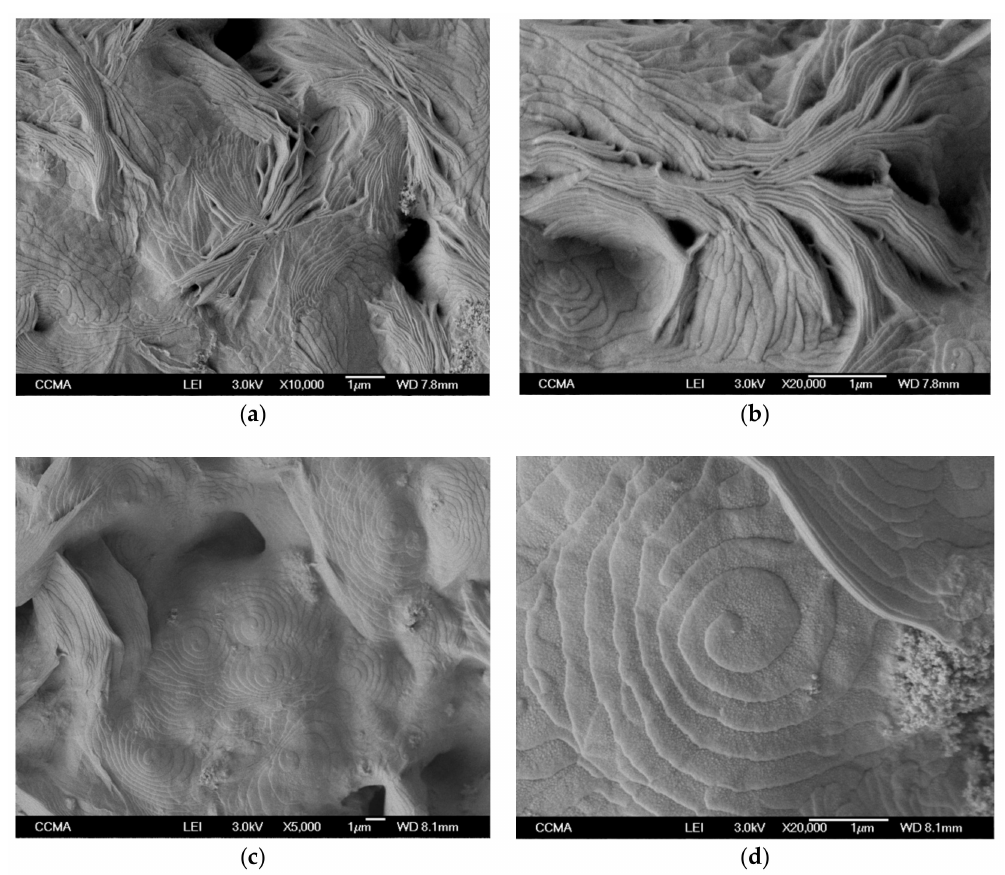
Figure 6. SEM micrograph of PTFE crystals formed in the presence of SiO 2 (c)F at ( a , b ) fast cooling rate (100 K · s − 1 ) and ( c , d ) slow cooling rate (0.1 K · s − 1